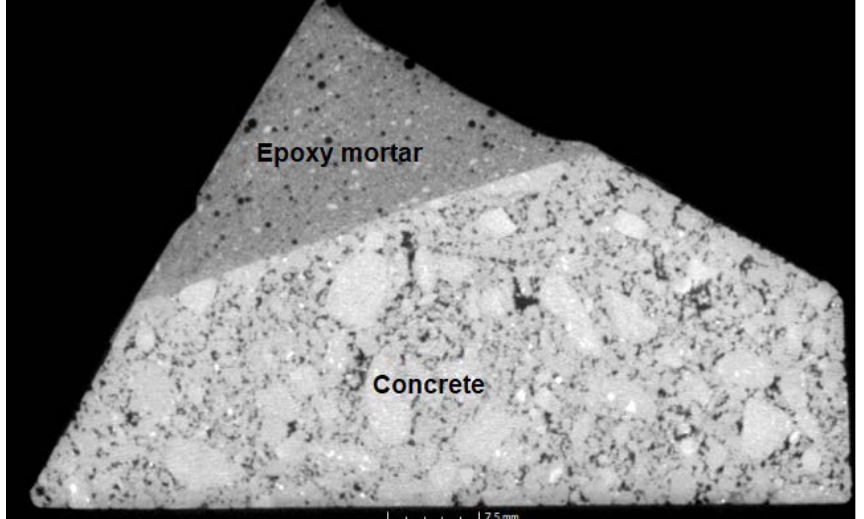
Figure 23. CT scan of the corner reprofiled by the epoxy composite containing RGI.